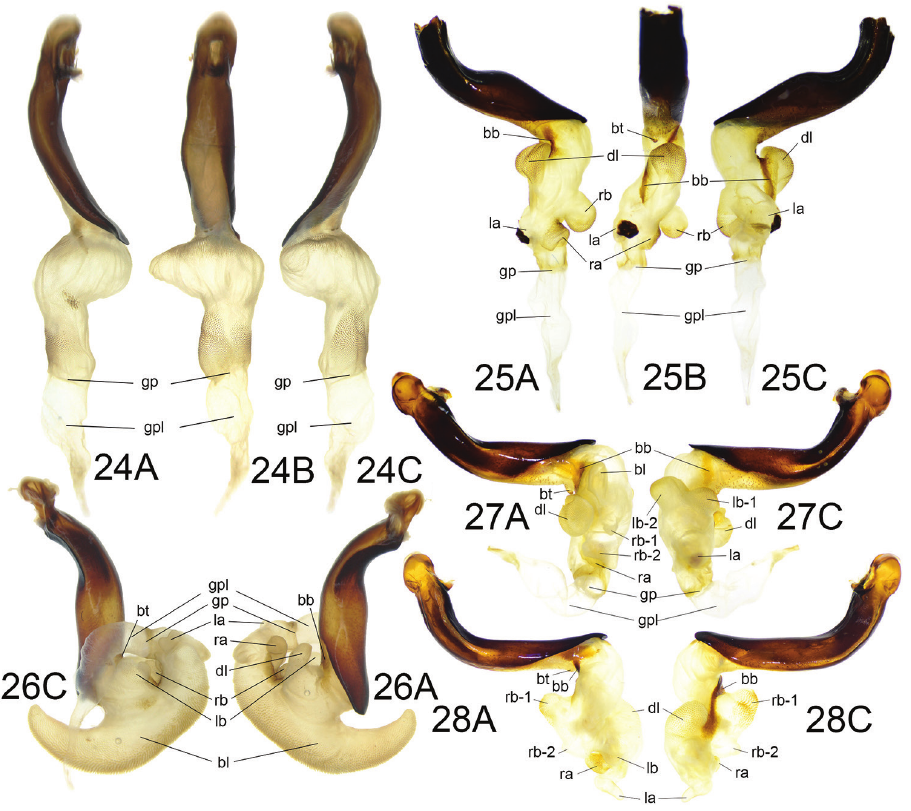
Figures 24–28. Endophallus of species representatives. A left lateral view B dorsal view C right lateral view 24 Trigonotoma lewisi Bates from Yunnan (type I) 25 Lesticus perniger Roux & Shi from Yunnan (type I) 26 Lesticus magnus (Motschulsky) from Liaoning (type III) 27 Lesticus auricollis Tschitschérine from Fujian (type I) 28 Lesticus insignis Gestro from Sabah (type